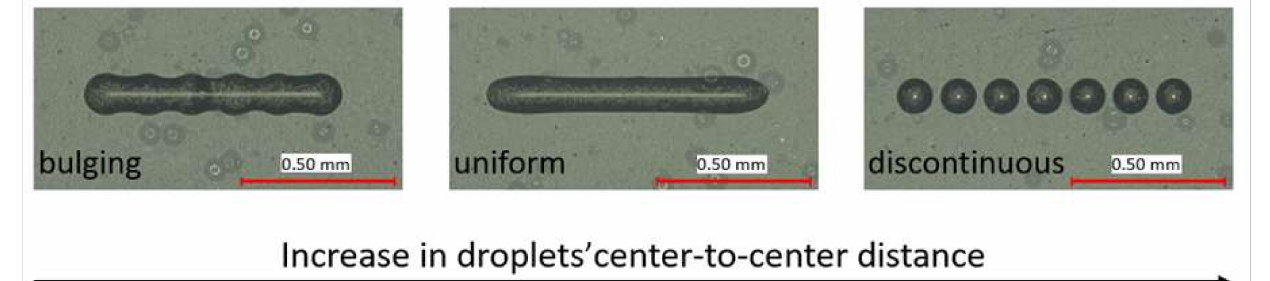
Figure 2. Impact of droplets’ center-to-center distance on line formation.